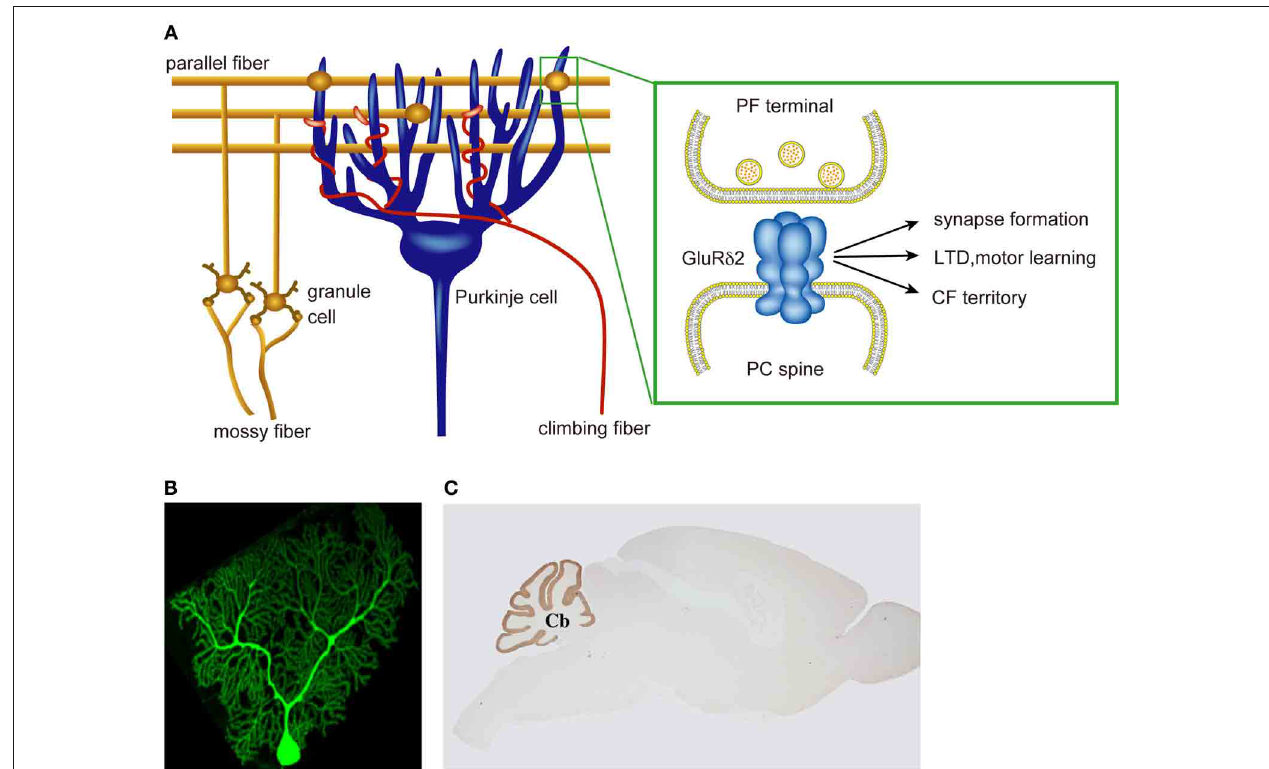
synapse. GluR δ 2 at the PF synapse regulates PF-PC synapse formation, LTD induction, motor learning, and CF territory. (B) A cerebellar PC visualizes by EGFP. (C) Immunohistochemical staining of a mouse brain with anti-GluR δ 2